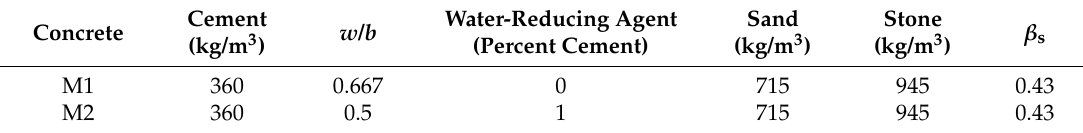
Table 7. The mix ratio of concrete.